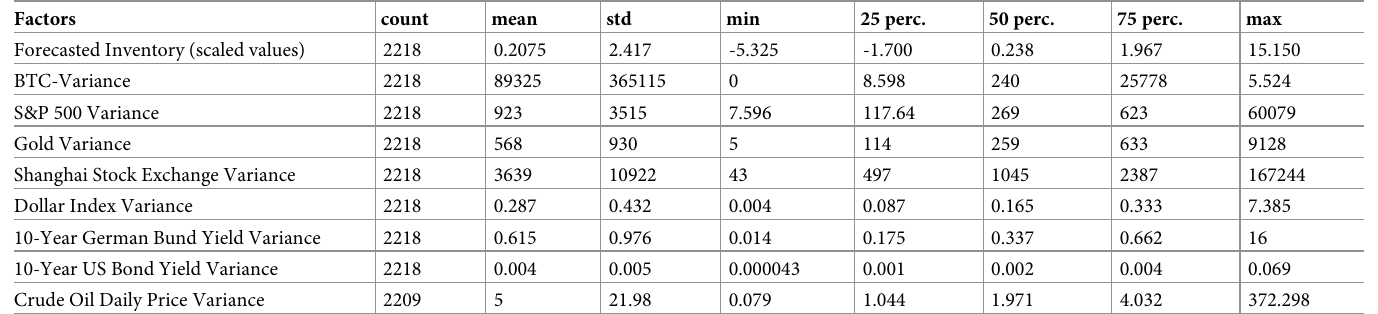
Table 2. Statistical Description of all the factors involved.